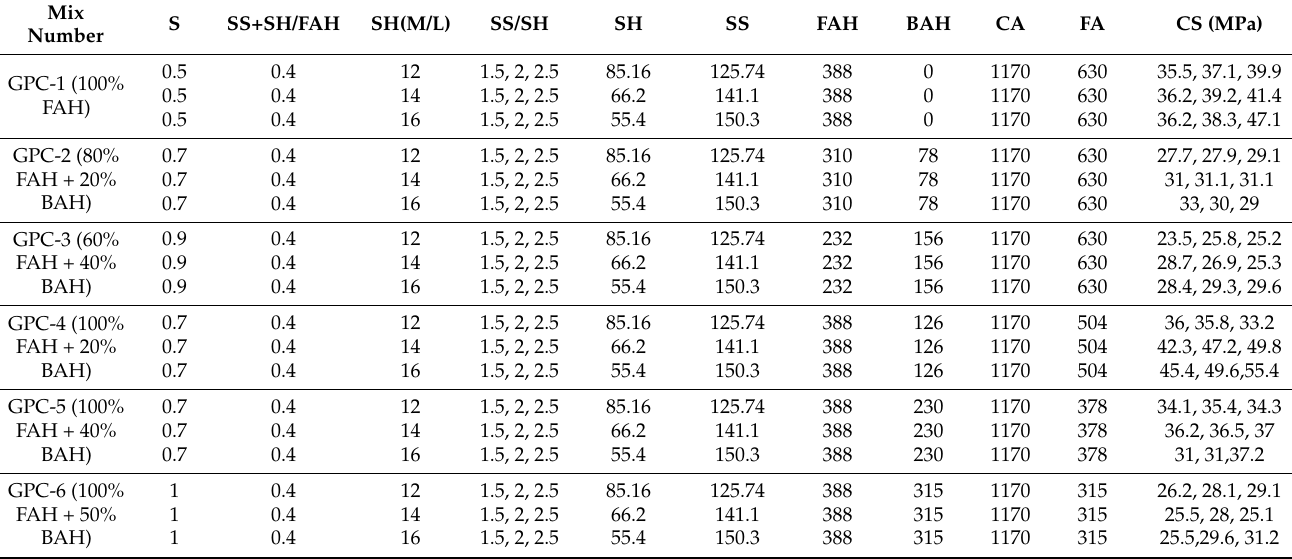
Table 4. Mix proportions for Fly ash-based geopolymer concrete with bottom ash as replacement of fly ash & fine